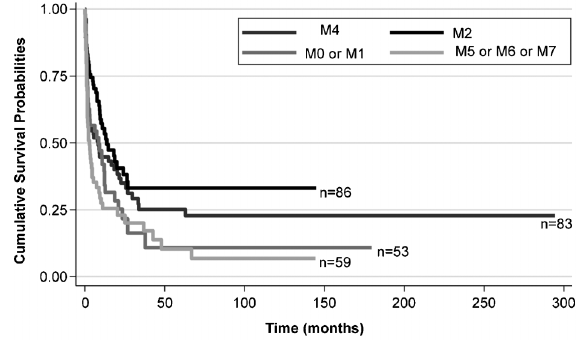
Figure 4. Disease-free survival of patients consolidated with cytarabine, by total dose administered. P , 0.001, comparing different doses (log-rank test).